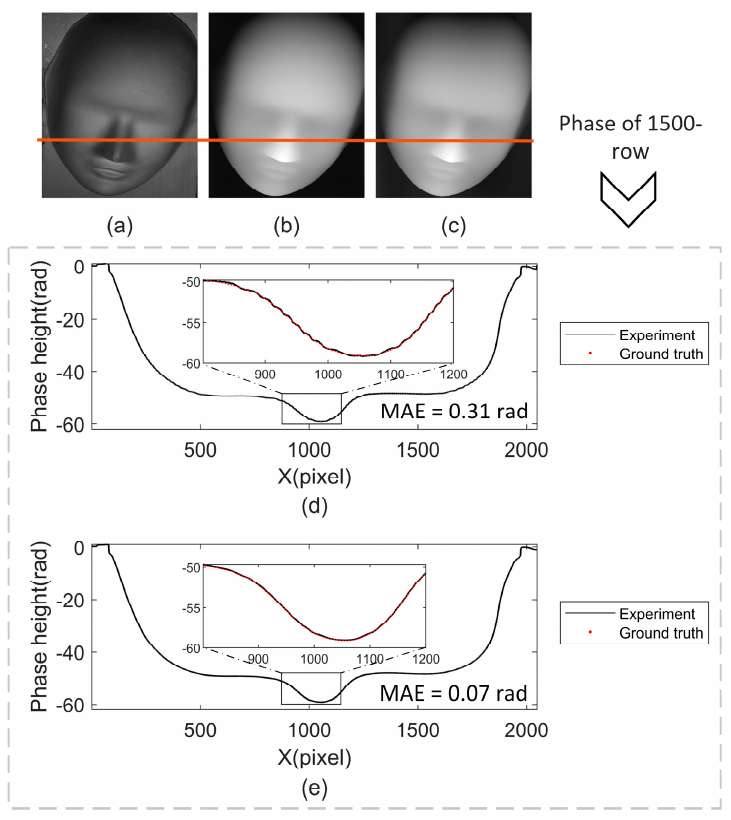
Figure 7. Experimental results of face measurement. ( a ) Object image; ( b ) result of LS method; ( c ) result of PWPE-NN method; ( d ) result of one row with LS method; ( e ) result of one row with PWPE-NN method.